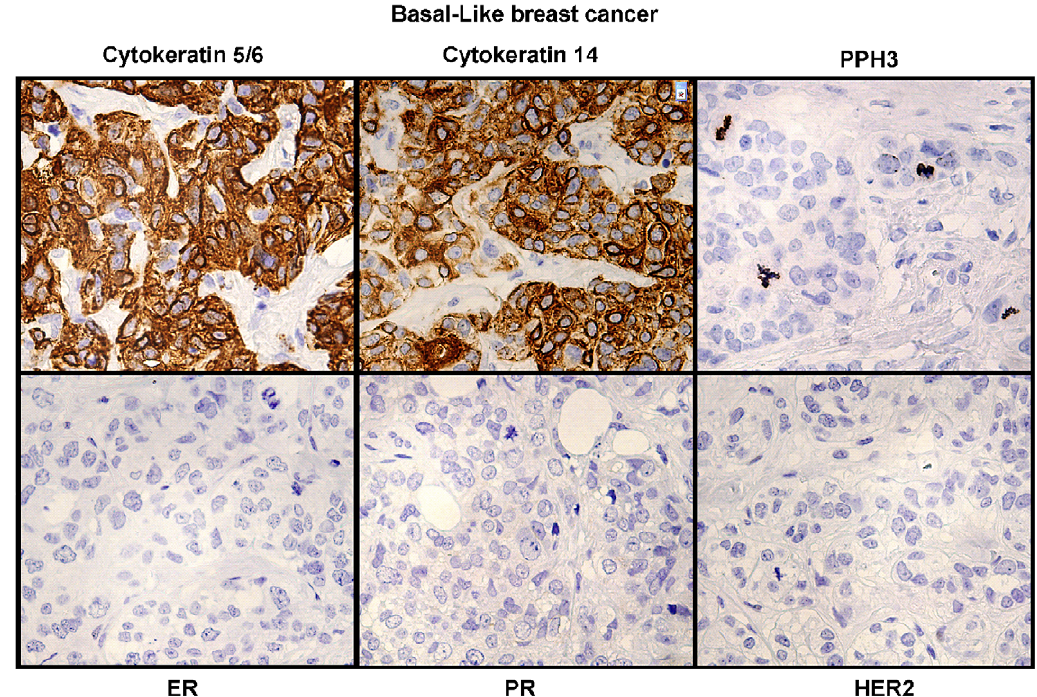
Fig. 1. Example of a basal-like breast cancer stained with Cytokeratin 5/6, Cytokerratin 14, Phosphohistone H3 (PPH3), Estrogen receptor (ER), Progesterone receptor (PR) and HER2.